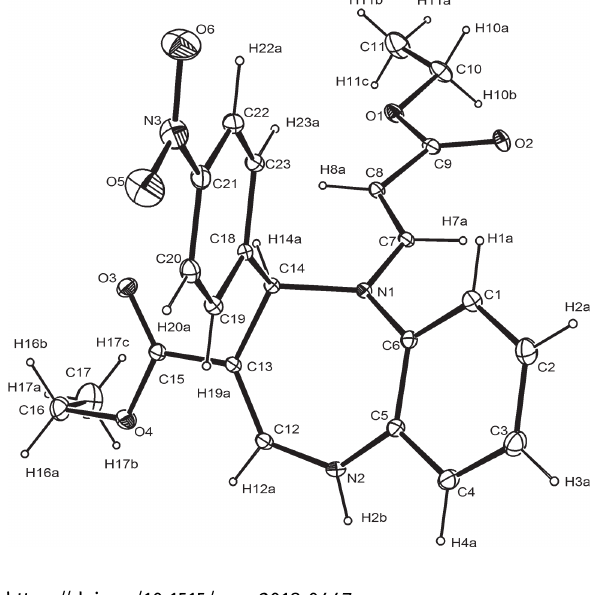
Table 1: Data collection and handling.